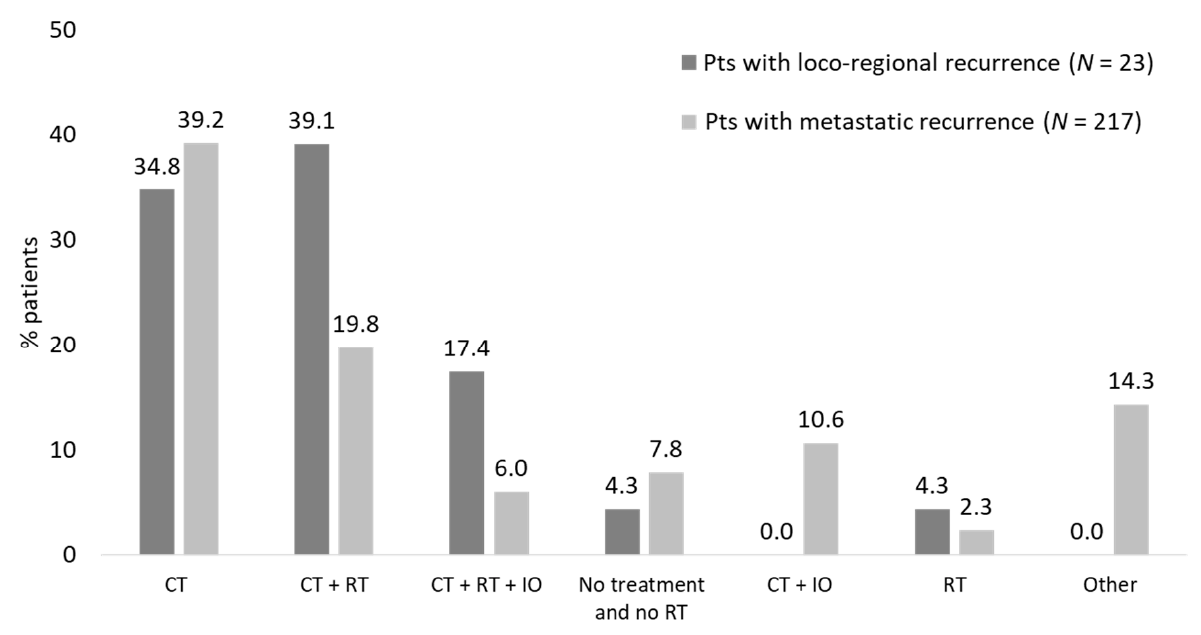
Figure 4. Therapeutic patterns after recurrence patients with eNSCLC in stage II–IIIA treated with chemotherapy after surgery divided according to the type of recurrence (study period January 2015– June